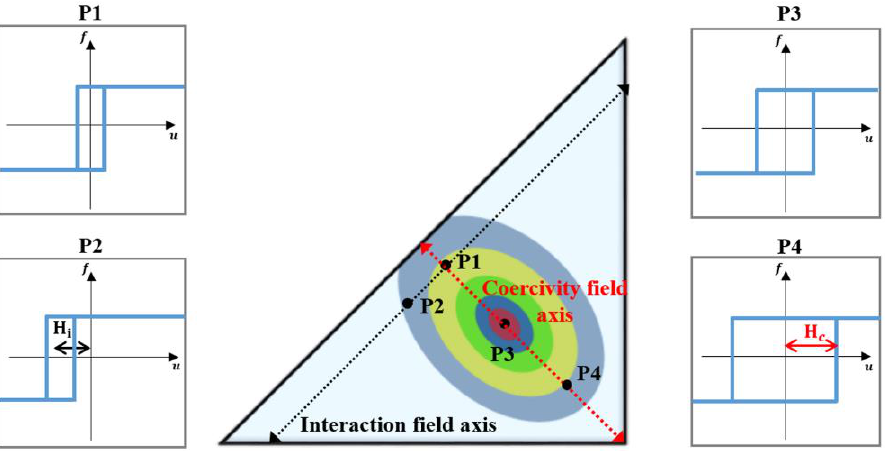
Figure 2. Schematic of Preisach density distribution according to coercivity field and interaction fields on the Preisach plane.